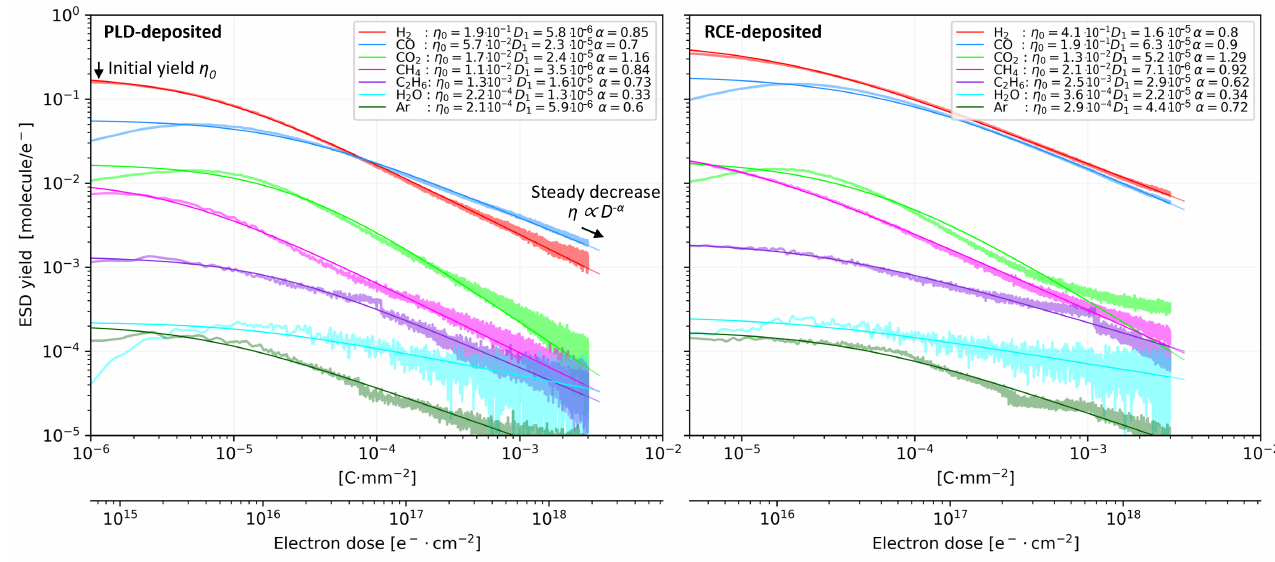
Figure 5. ESD dose dependence measured at 300eV for PLD–deposited ( left ) and RCE–deposited ( right ) REBCO samples held at 12K starting from an as–received state. Best–fit parameters for Equation (5) from [49] is listed in the legend. More details are in the